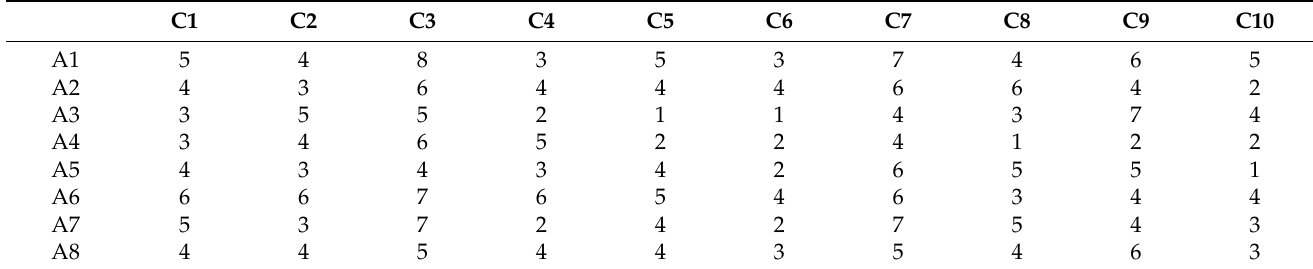
Table 3. Initial decision matrix for market-oriented business regulatory risk assessment.